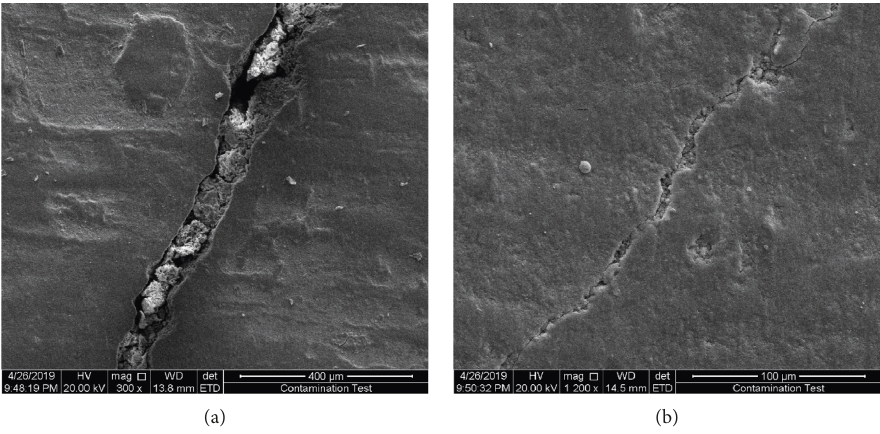
Figure 12: Microimages of